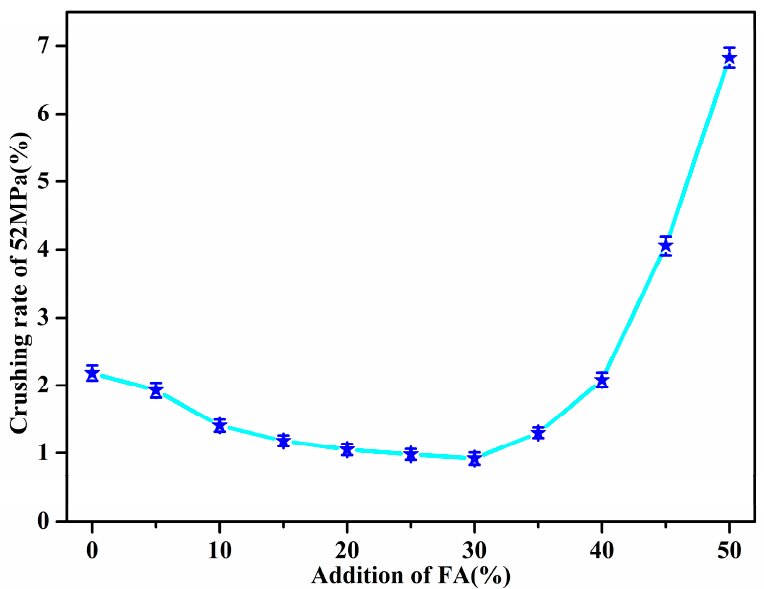
Figure 7. Crushing rate at 52 MPa of poly(St- co -MMA)/FA microspheres.